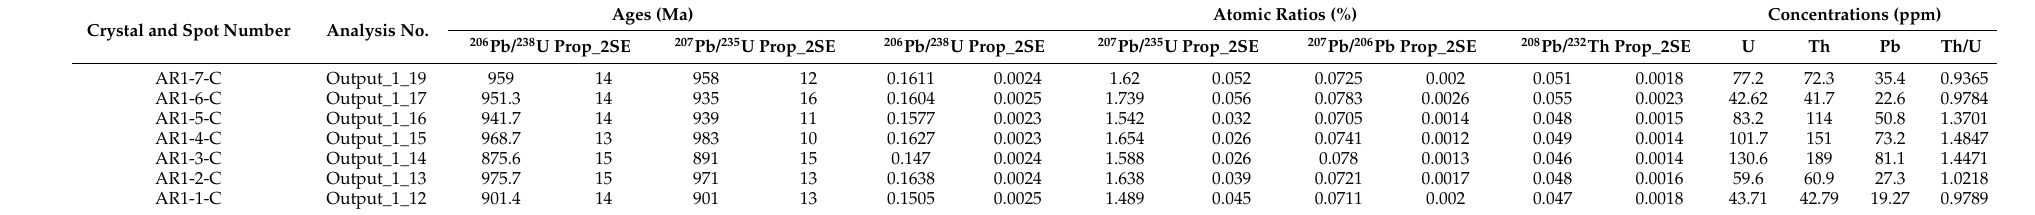
Table 2. Trace element and U-Pb isotopic results (zircon from Araru black to whitish gneiss) with C in the spotted area.